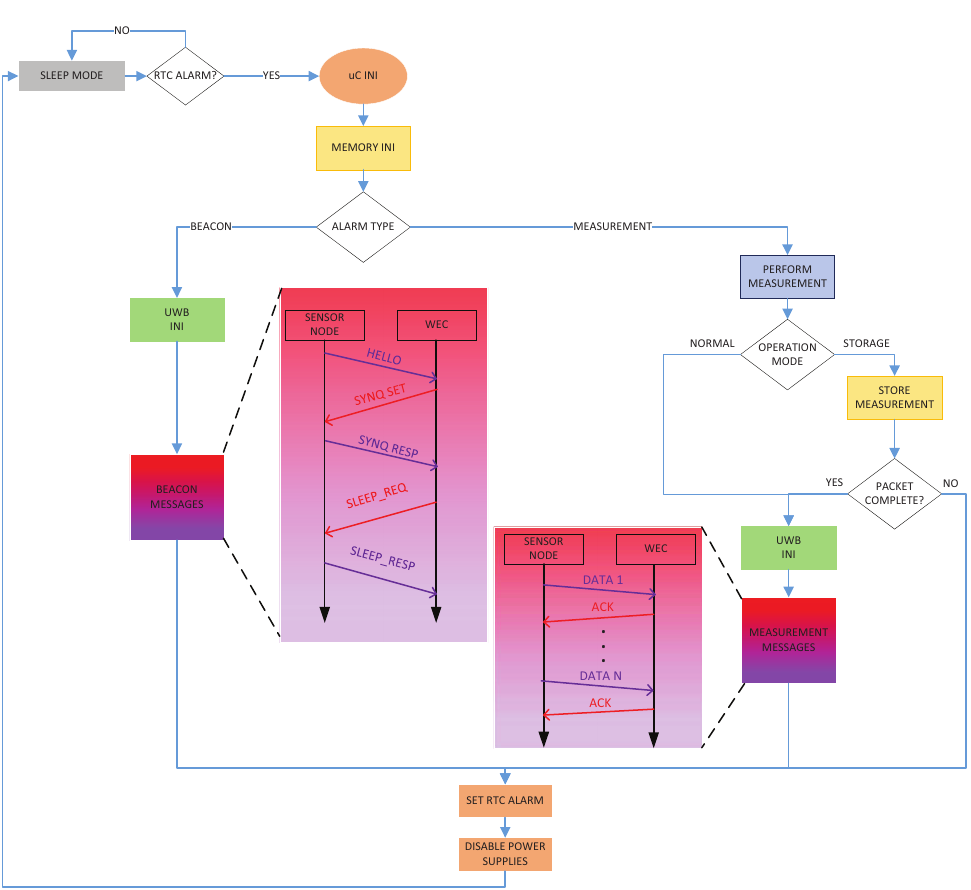
Figure 5. Sensor Node flow